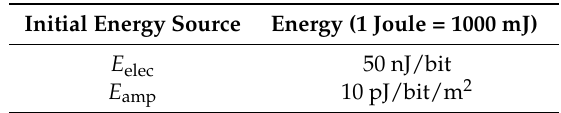
Table 2. Values of mapping parameters of the proposed energy